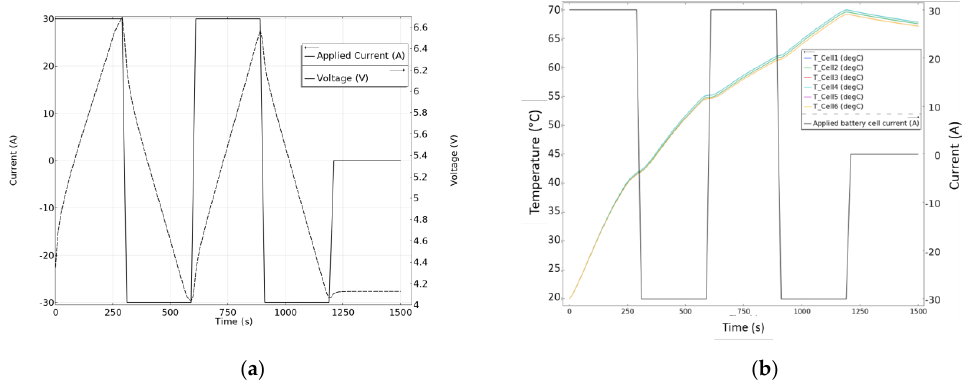
Figure 7. ( a ) Change in current and voltage during the discharge – charge cycle of batteries; ( b ) temperature rise vs. applied current.